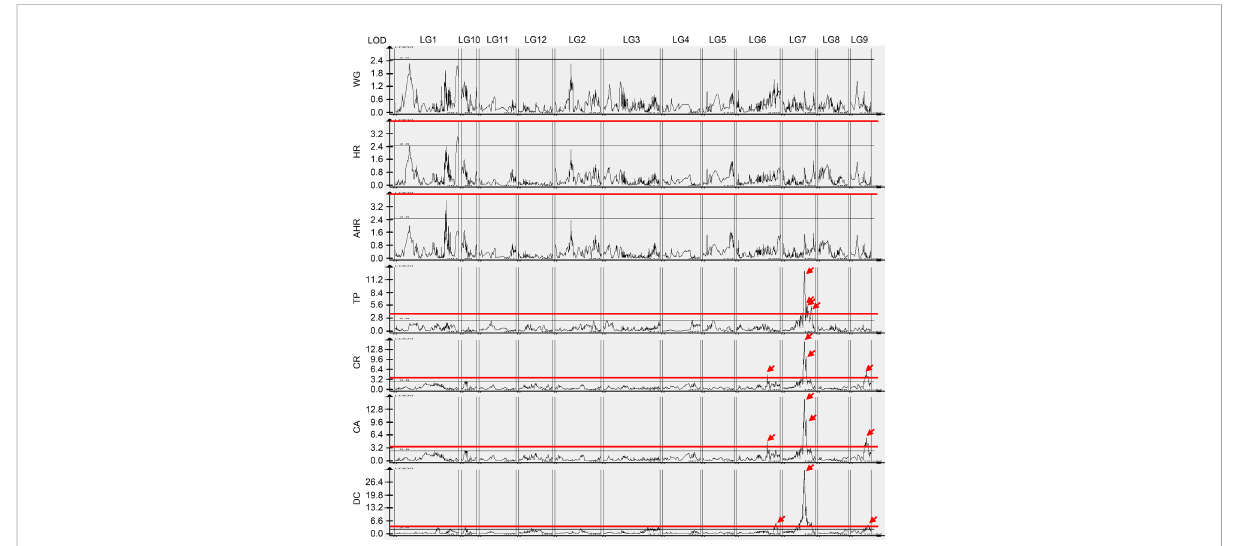
FIGURE 5 Quantitative trait loci for rice grain quality traits. The black line indicates LOD = 2.5, the red line indicates LOD = 4, and the red arrow indicates the LOD peaks of QTLs >4. WG, percentage of whole grain; HR, percentage of head rice; AHR, percentage of the area of head rice; TP, transparency; CR, percentage of chalky rice; CA, percentage of chalkiness area; DC, degree of